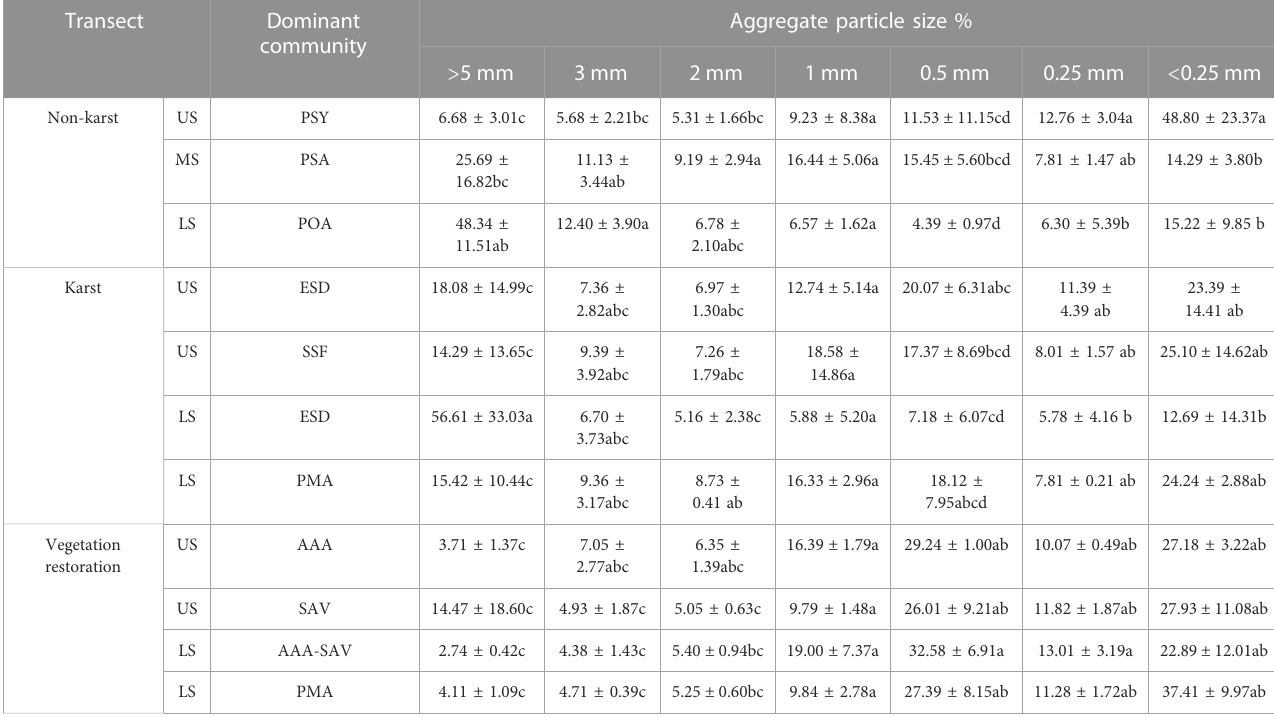
TABLE 3 Particle size composition of surface soil aggregates in different zones.